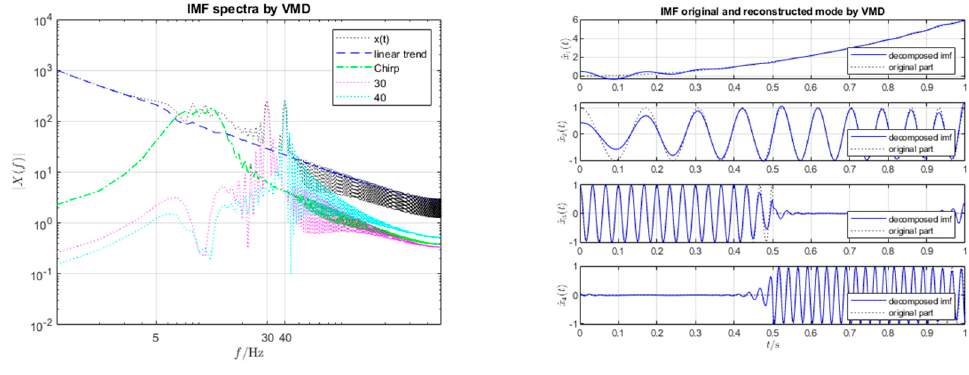
Figure 5. VMD decomposition of x Sig2 ( t ) .